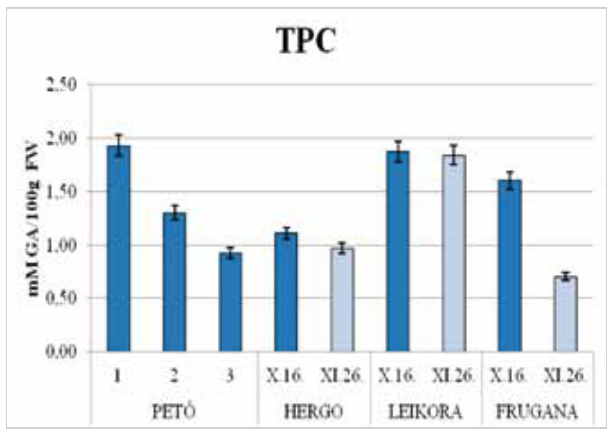
Figure 2. Total phenolic content in sea buckthorn berries according to genotypes and harvest